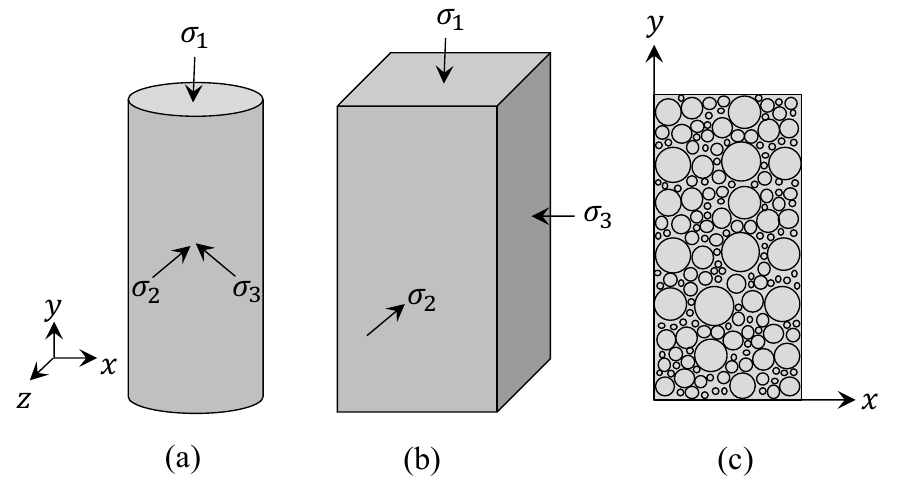
Figure 4. The stress condition in triaxial compression/extension tests ( a ) cylindrical sample, ( b ) block sample, ( c ) axisymmetric/biaxial representation of solid and fluids in the sample.